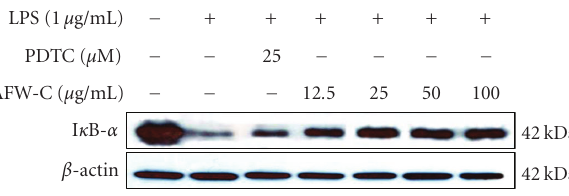
Figure 6: E ff ects of CH 2 Cl 2 fraction from A. koreanum on the degradation of I κ B- α in LPS-stimulated RAW 264.7 cells. RAW 264.7 cells (1.0 × 10 6 cells/mL) were stimulated with LPS (1 μ g/mL) in the presence of A. koreanum (12.5, 25, 50, 100 μ g/mL) for 15 minutes. As a control, we also applied PDTC (25 μ M), a specific NF- κ B inhibitor. Whole cell lysates (25 μ g) were prepared and the protein was subjected to 12% SDS-PAGE. Expression of I κ B- α and β -actin were determined by western blotting. β -Actin served as a loading control.